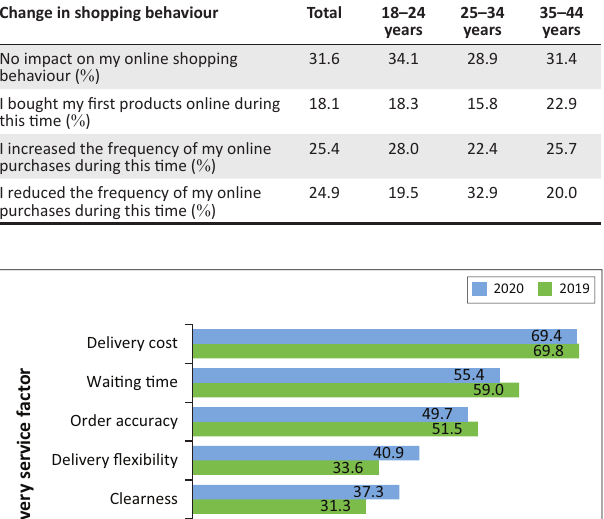
TABLE 3: Change in online shopping behaviour. Change in shopping behaviour